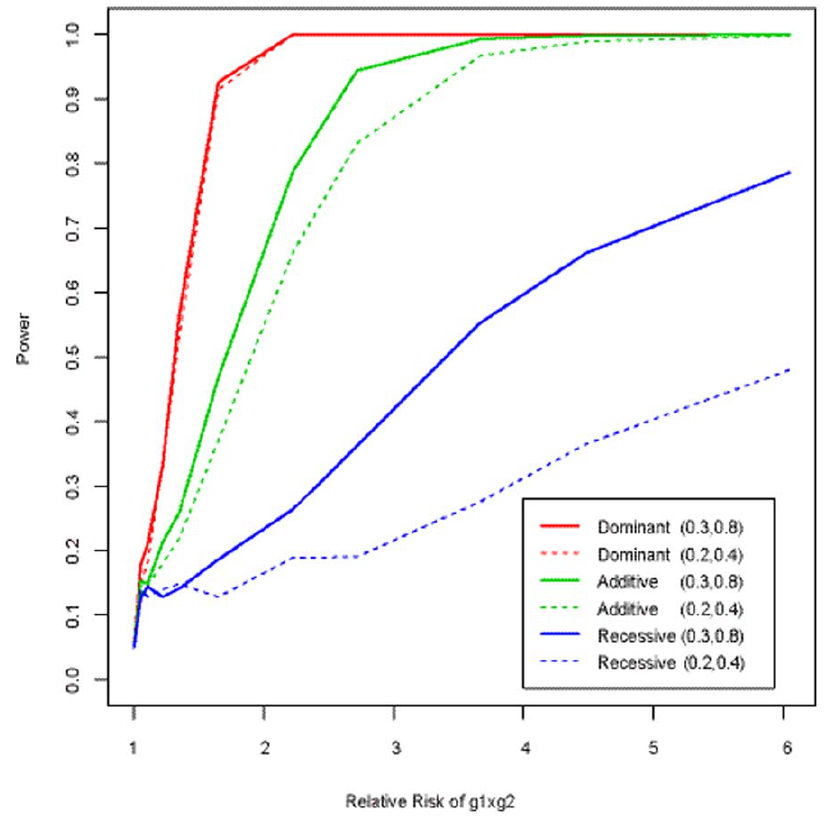
Figure 6. Power of Fst under different parameter settings. The disease prevalence is assumed to be 1%. The power, at significance level a of 0.05, is obtained based on simulations of 500 cases and 500 controls. Three solid colorful lines (red, green and blue) correspond to the power curves of the Fst- based statistic under three genetic models (dominant, additive and recessive), when the disease allele frequencies at the two loci (g1 and g2) are 0.3 and 0.8, respectively. The dotted lines are the power curves under the assumption that the disease allele frequencies at the two loci are 0.2 and 0.4, respectively.